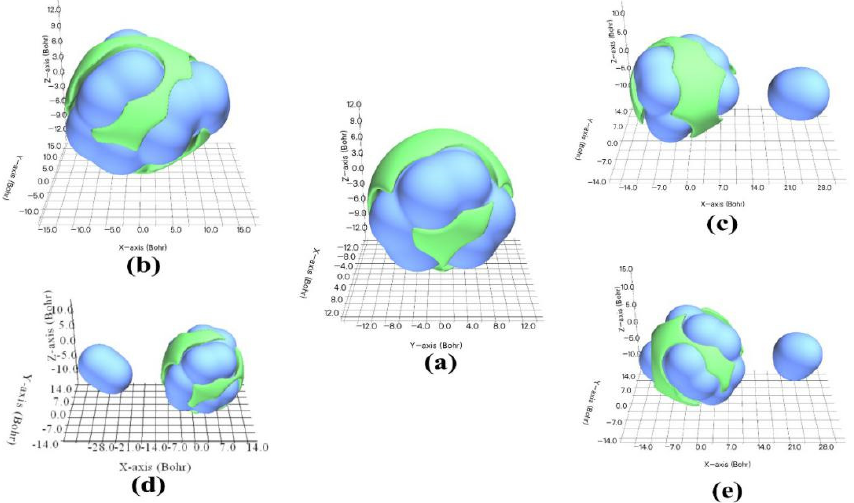
Figure 12. An amount of 0.5 kcal/mol isosurface of vdW potential of CL-20 and its complexes: ( a ) CL-20, ( b ) CL-20/H 2 O 2 , ( c ) CL-20/CO 2 , ( d ) CL-20/N 2 O, and ( e ) CL-20/H 2 O, respectively. Green and blue surfaces correspond to negative and positive parts, respectively.